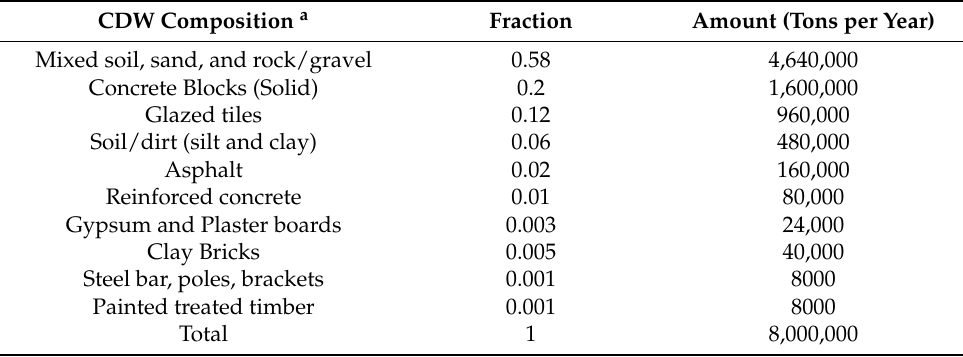
Table 1. Composition and quantities of CDW in Riyadh (Source: [19]).